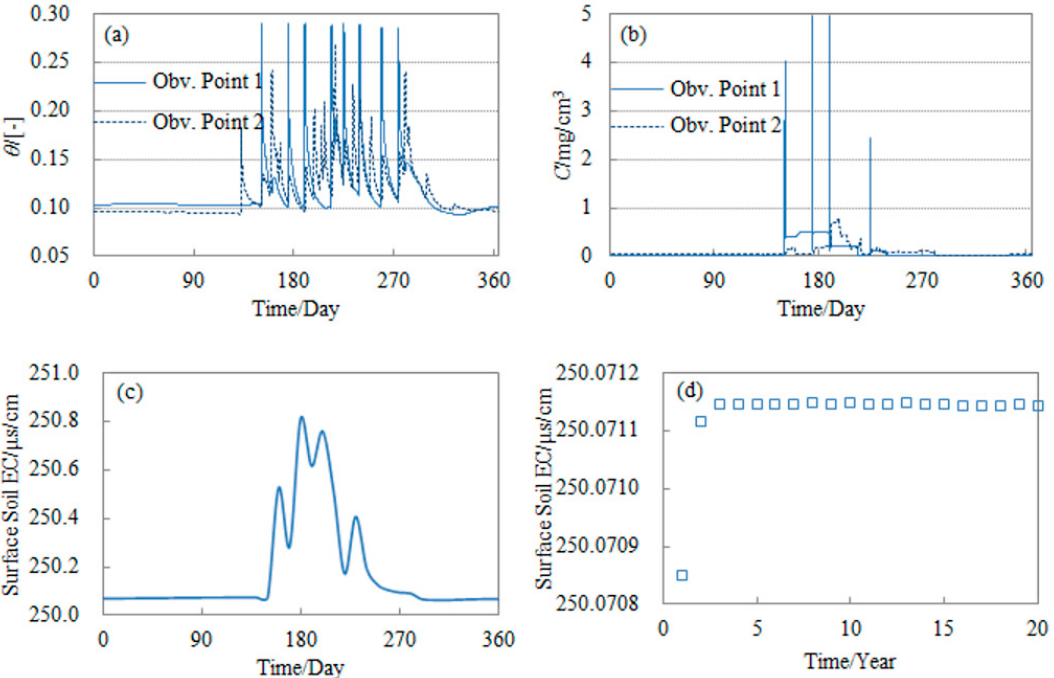
Figure 7. Annual and interannual changes in water and salt in mulched drip irrigation. ( a ) Water content at observation point; ( b ) concentration of soil solution at observation point; ( c ) annual variation in topsoil salinity; ( d ) interannual variation in topsoil salinity.